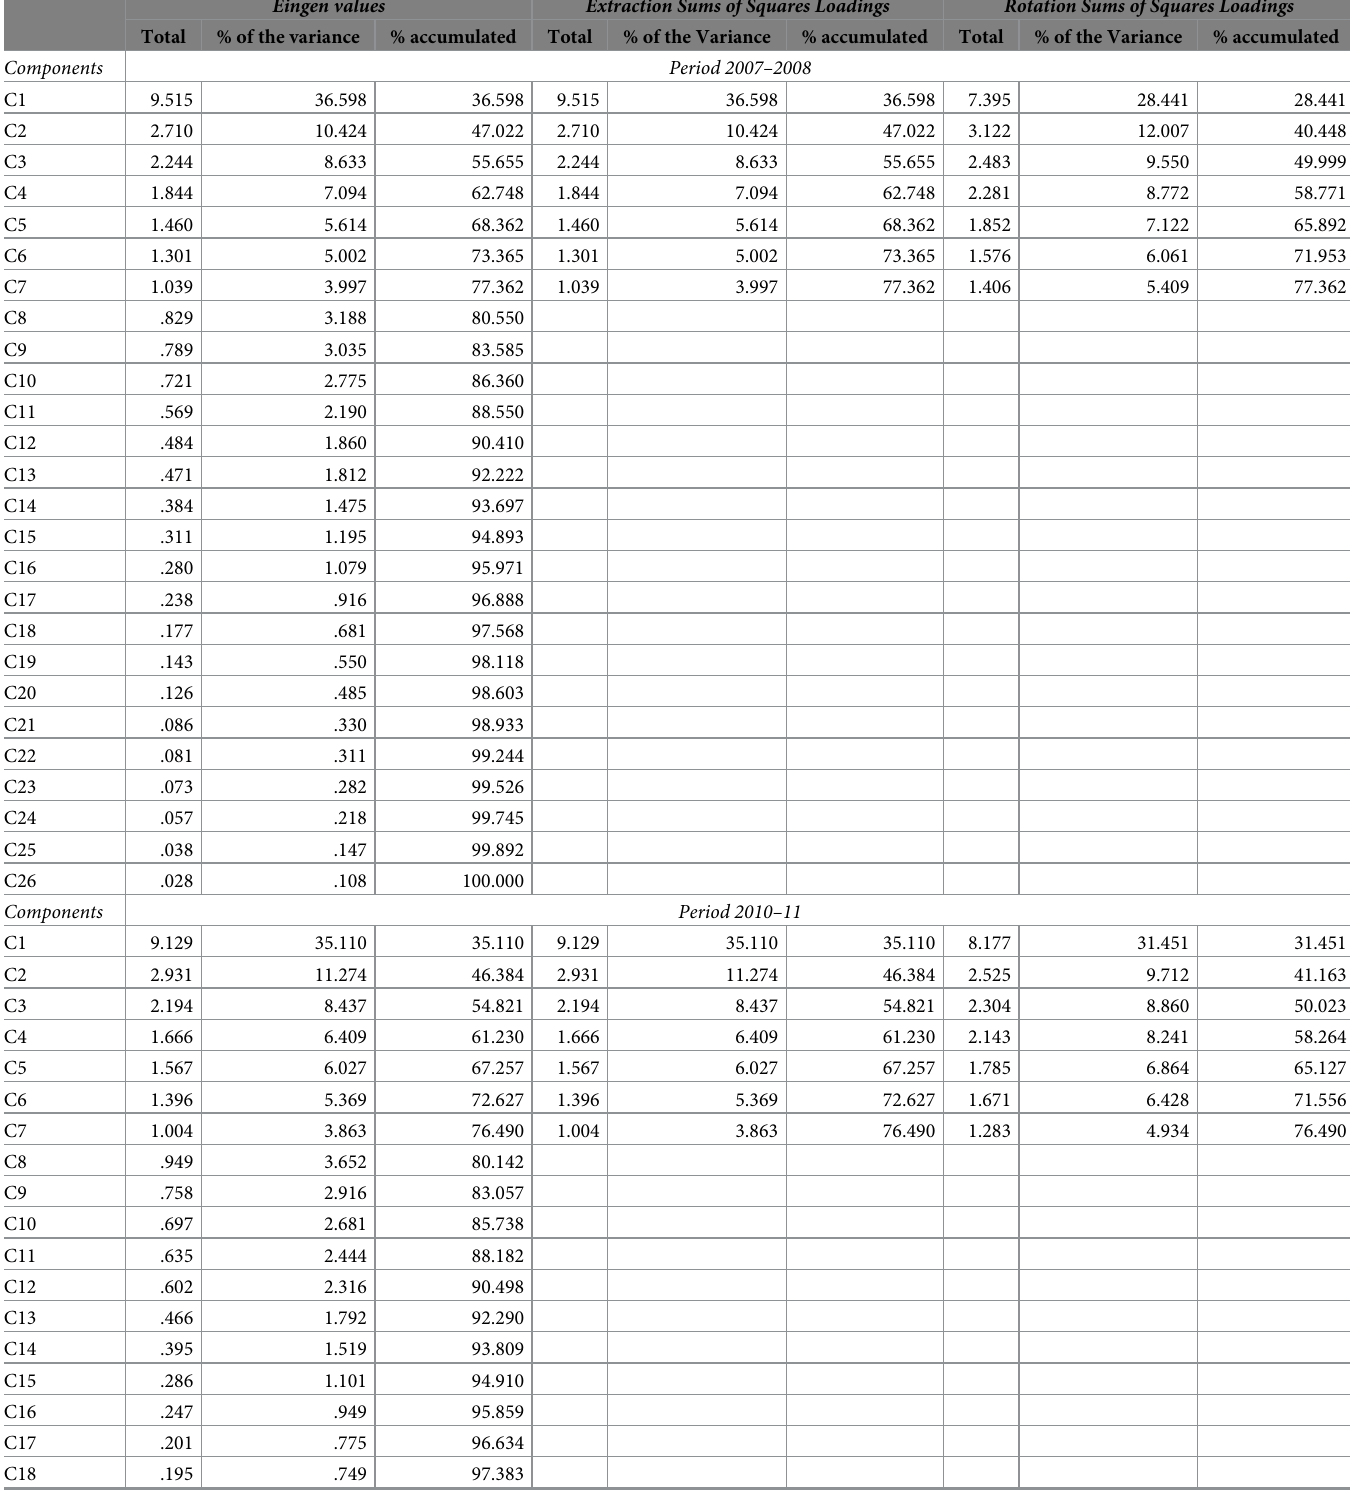
Table 4. Total explained variance. Principal component